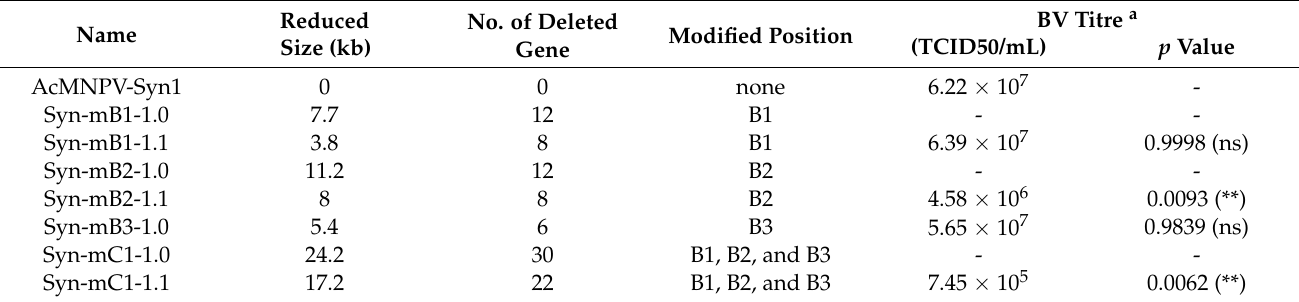
Table 2. Summary of the synthesised genomes and the rescued